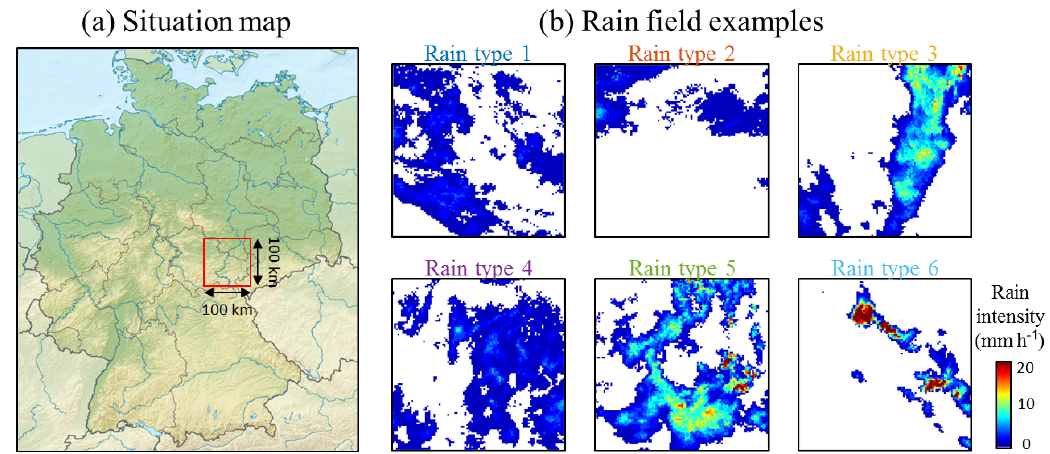
Figure 2. Radar dataset used for rain typing. (a) Study area. The red square denotes the area of interest, centered on Jena, Thuringia, Germany. (Background map from https://www.wikipedia.org/, last access: 27 May 2020, licensed under CC BY 3.0.) (b) Example of RADOLAN radar images (cropped over the area of interest) for each rain type.